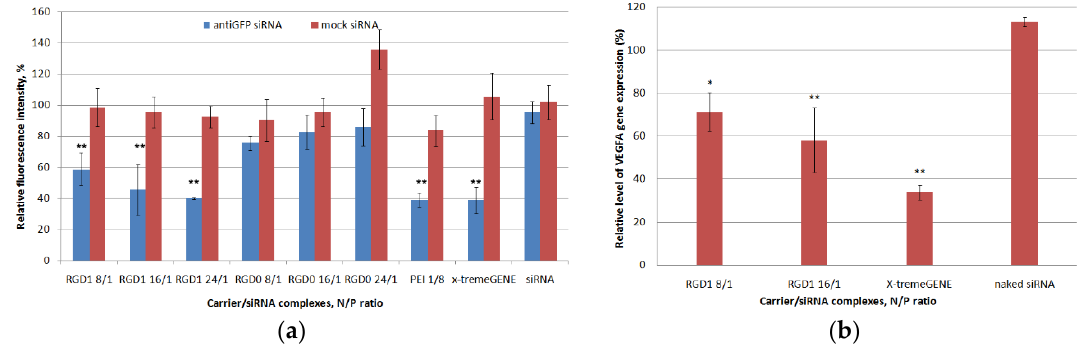
Figure 10. siRNA transfection efficacy evaluation: ( a ) reduction of GFP production after treatment of MDA-MB-231 cells with carrier/siRNA complexes. ** p < 0.01 when compared with cells treated by naked anti-GFP siRNA. The data are shown as the mean ± S.E.M. ( b ) reduction of VEGFA gene expression after treatment of E.A.Hy926 cells with carrier/siRNA complexes. The level of VEGFA gene expression after delivery of mock siRNA was taken as 100%. * p < 0.05, ** p < 0.01 when compared with cells treated by naked mock siRNA. The data are shown as the mean ±S.E.M.